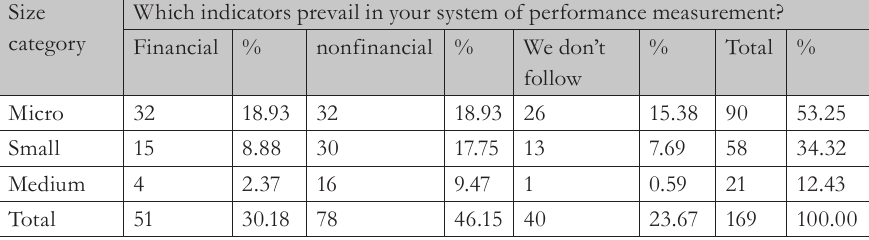
Tab. 5 – Types of KPIs in transportation SMEs. Source: own